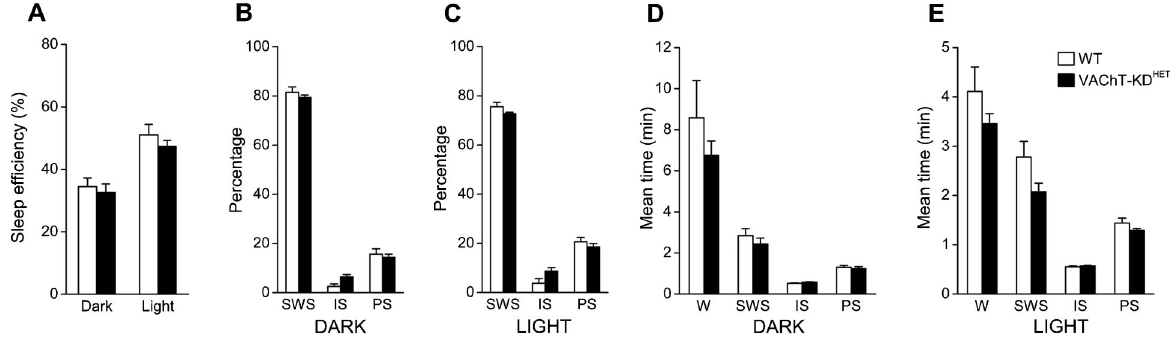
Figure 3. Circadian profile of the sleep-wake cycle. A , Sleep efficiency quantified during the dark and light phase (sleep efficiency %: amount of time spent in sleep/total time). B , C , Relative amount of time spent in slow-wave sleep (SWS), intermediate sleep (IS) and paradoxical sleep (PS) during the dark ( B ) and light ( C ) phases. D , E , Averaged episode duration for each of the behavioral states quantified during the dark ( D ) and light ( E ) phases. WT: wild-type mice (n=7); VAChT-KD HET : vesicular acetylcholine transporter knockdown heterozygous mice (n=7); W: awake. Data are reported as